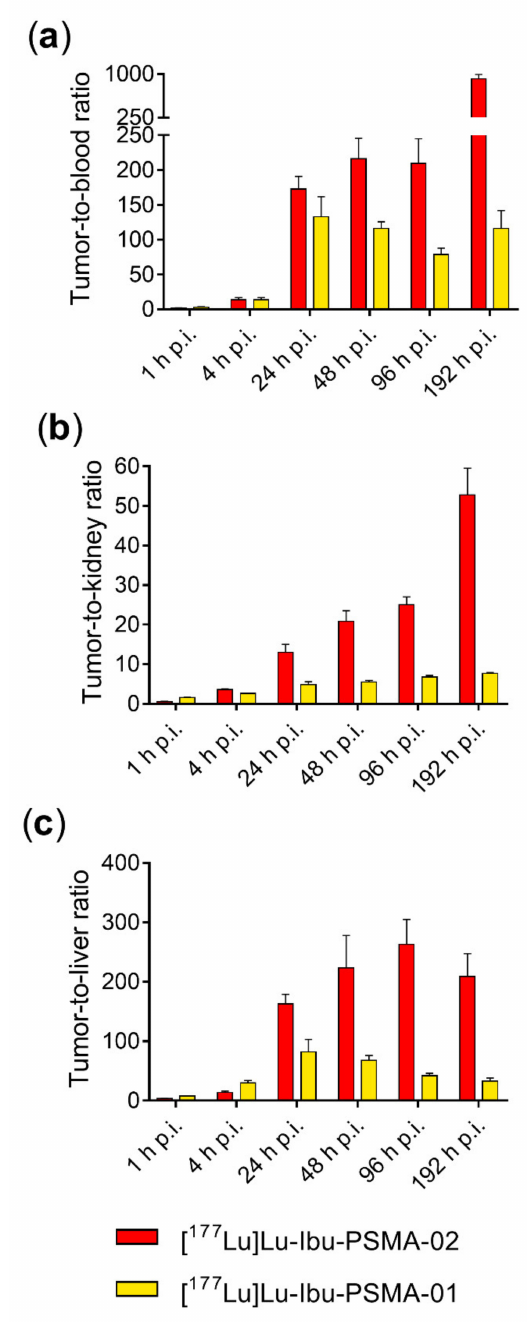
Figure 5. ( a ) Tumor-to-blood ratios; ( b ) tumor-to-kidney ratios and ( c ) tumor-to-liver ratios at 1, 4, 24, 48, 96 and 192 h after injection of [ 177 Lu]Lu-Ibu-PSMA-02 in comparison to [ 177 Lu]Lu-Ibu-PSMA-01